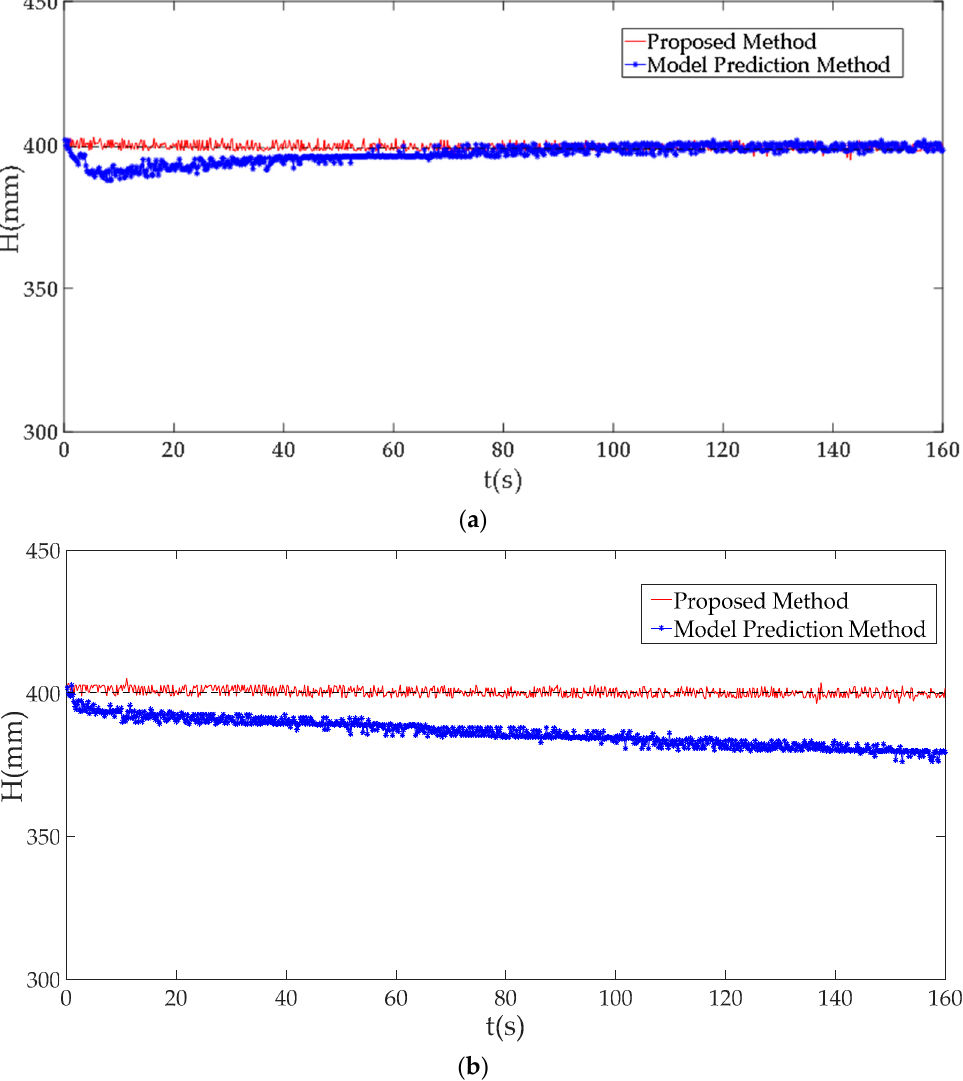
Figure 20. The comparison of results using different methods. ( a ) Experimental results under a DoS attack rate of 1,000; ( b ) Experimental results under a DoS attack rate of 10,000.